Question: In a single sentence, describe what this figure presents.
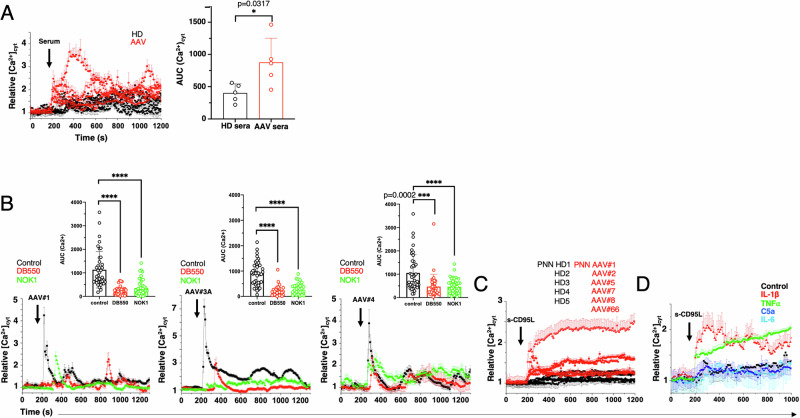
Answer: AAV neutrophils are primed to respond to sCD95L. Cytosolic calcium concentration ([Ca 2+ ] cyt ) was assessed using Cal-520-AM. Ratio values ( R ) were normalized to pre-stimulated values ( R 0 ) to yield R / R 0 values (relative [Ca 2+ ]). Data represent the mean ± SD ( n = 41 cells). Data are representative of three independently performed experiments. Sera were injected, and calcium responses were monitored in neutrophils isolated from healthy donors and AAV patients. A Left panel: Relative Cytosolic Ca 2+ concentration in neutrophils isolated from HD and exposed to sera of AAV patients or healthy donors. For each condition, data represent mean ± SD of n = 41 cells. Right panel: histograms of areas under the curve (AUC) of the cytosolic Ca 2+ concentration measured in the left panel. Data represent mean ± SD; * p < 0,05 using two-tailed Mann-Whitney test. B Cytosolic Ca 2+ concentration was assessed in HD neutrophils stimulated with sera from AAV patients. Briefly, neutrophils were pre-incubated in the presence or absence of DB550 (1 µM) for 30 min and then incubated with sera of AAV patients. To block CD95L/CD95 interaction, the neutralizing anti-CD95L mAb NOK-1 or isotypic control (1 µg/ml) was pre-incubated in the indicated sera for 10 min prior to incubation with HD neutrophils. For each condition, data represent mean ± SD of n = 41 cells . Insets : Cytosolic Ca 2+ concentration AUC of indicated conditions. Data represent mean ± SD; *** p < 0.001, **** p < 0.0001 using unpaired and two-tailed Mann-Whitney test. C Neutrophils isolated from AAV patients or healthy subjects were stimulated with sCD95L (100 ng/mL) and cytosolic Ca 2+ concentration was monitored. For each condition, data represent mean ± SD of n = 41 cells. Data are representative of three independently performed experiments. D Cytosolic Ca 2+ concentration was assessed in PNN from HD, which were pre-incubated pre-treated in the presence or absence (control) of the pro-inflammatory cytokines TNF (